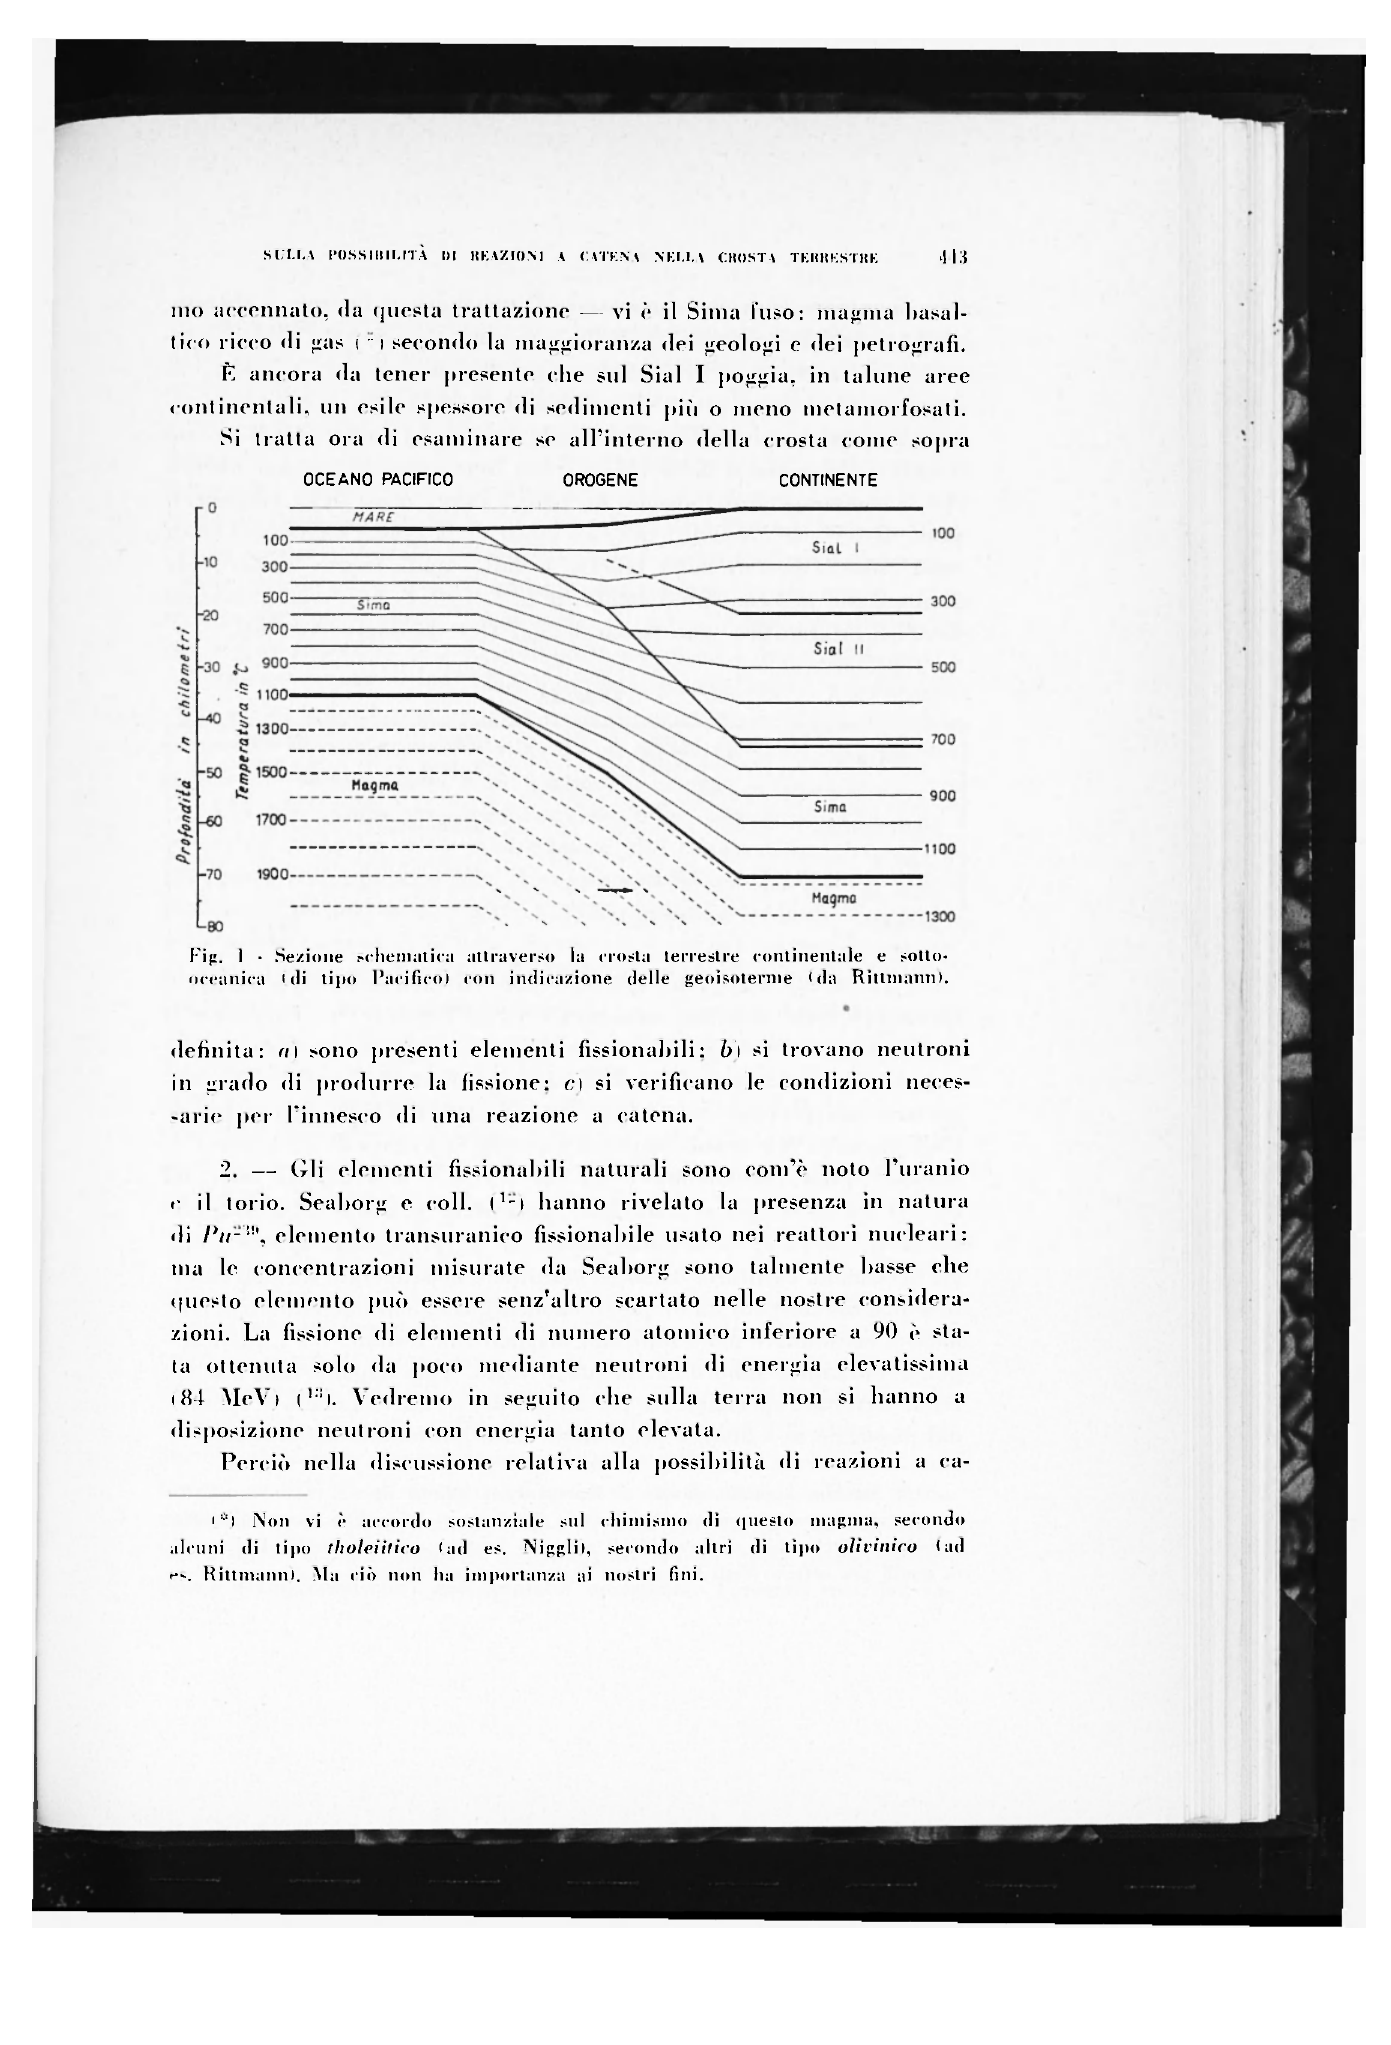
Fig. 1 • Sezione schematica attraverso la crosta terrestre continentale e sotto- oceanica idi tipo Pacifico! con indicazione delle geoisoterme Ida Rittmann).